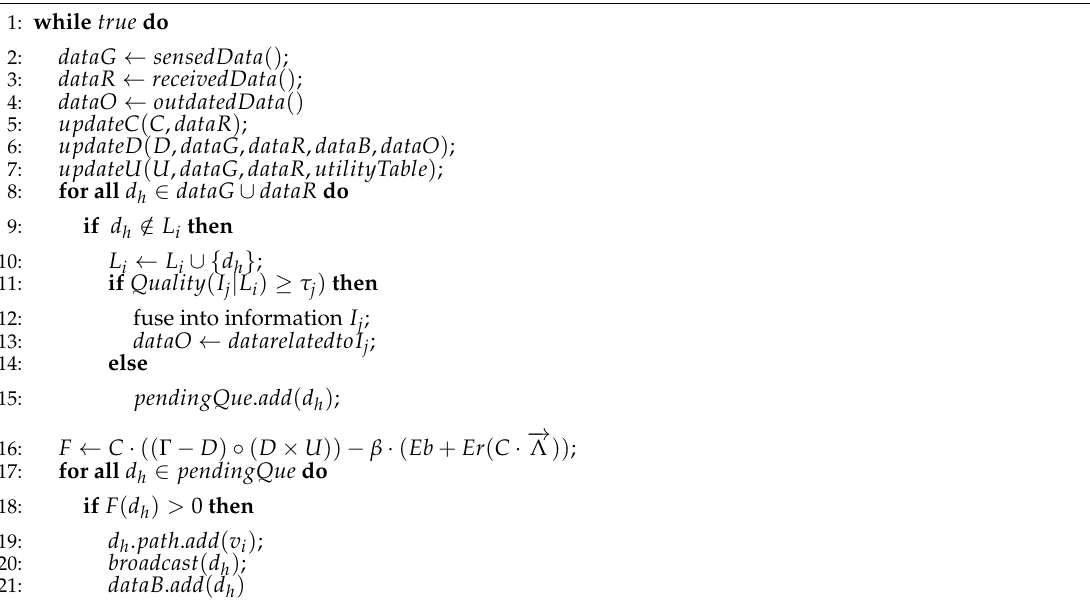
Algorithm 4 Data relay process for a sensor v i